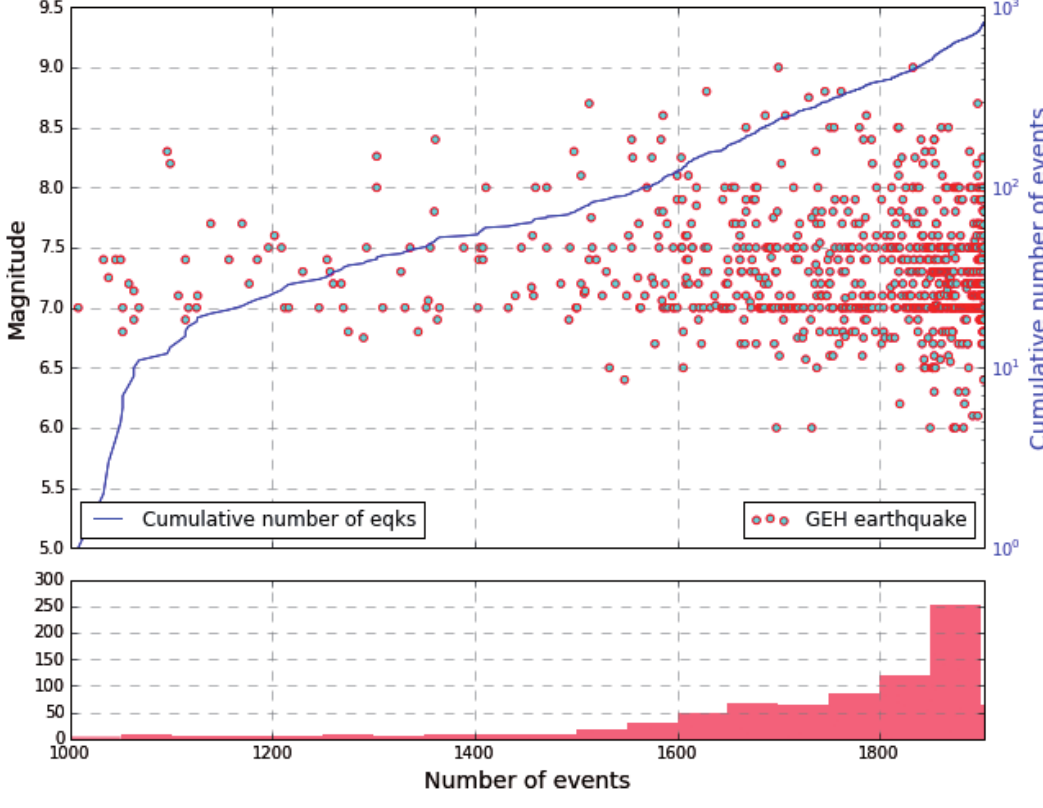
Figure 3. Time-magnitude space plotting of the earthquakes included in the GEH